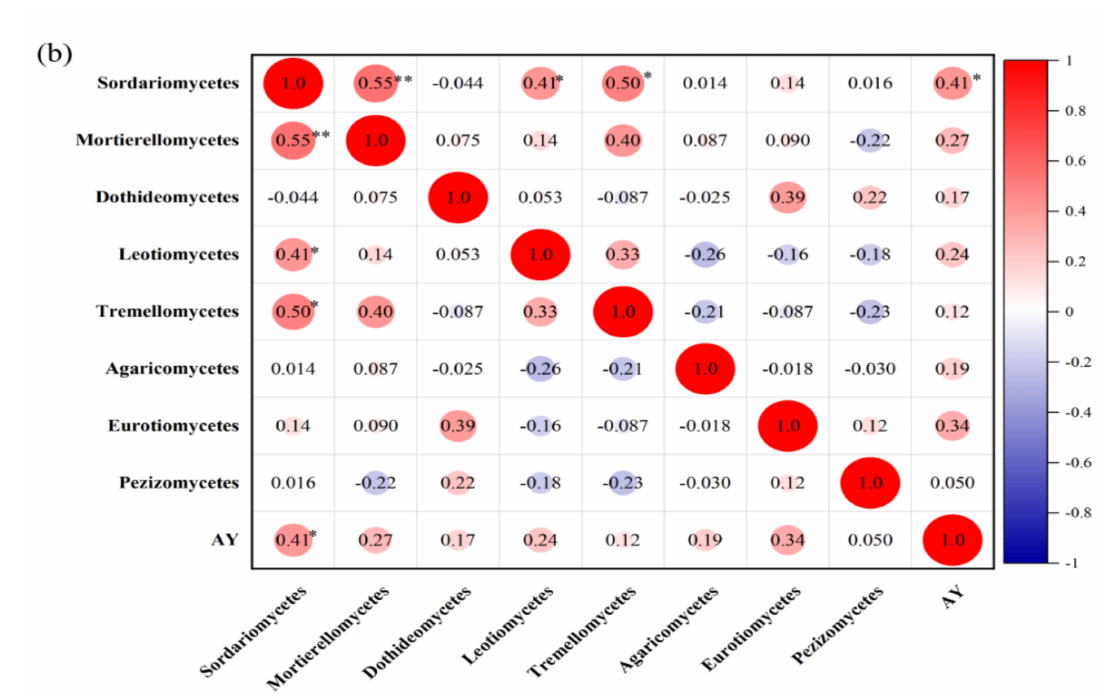
Figure 7. Correlation analysis of yield and dominant soil fungi at phylum ( a ) and class ( b ) levels. *, ** Significant at P < 0.05 and P < 0.01,